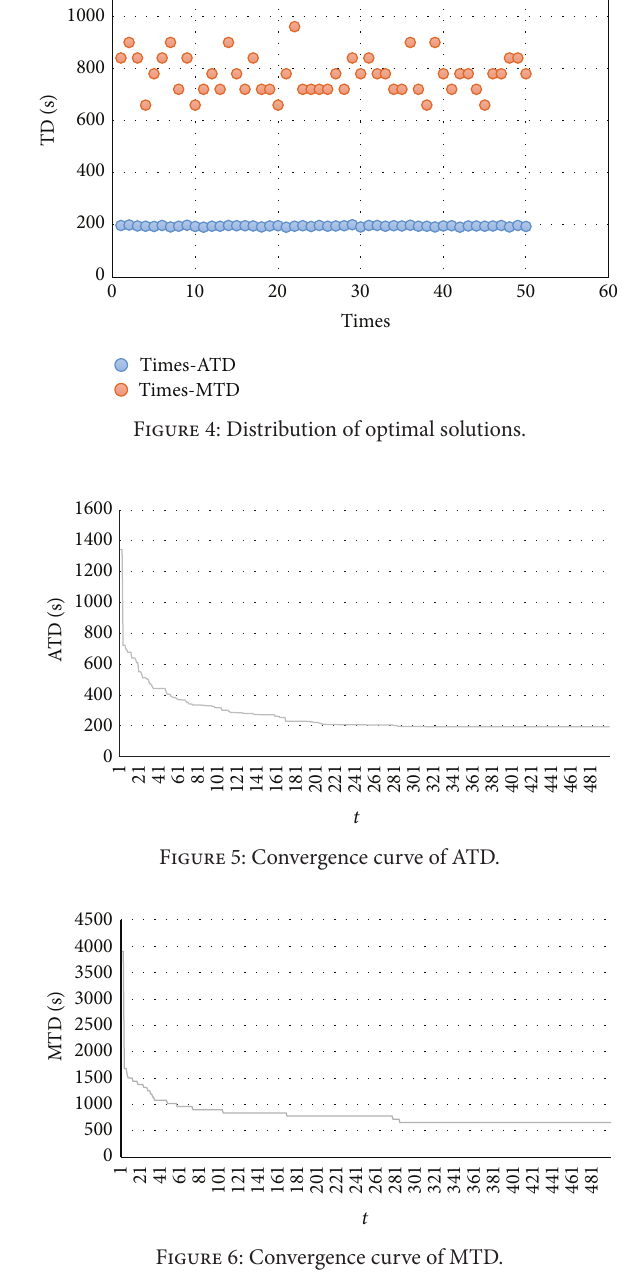
Figure 6: Convergence curve of